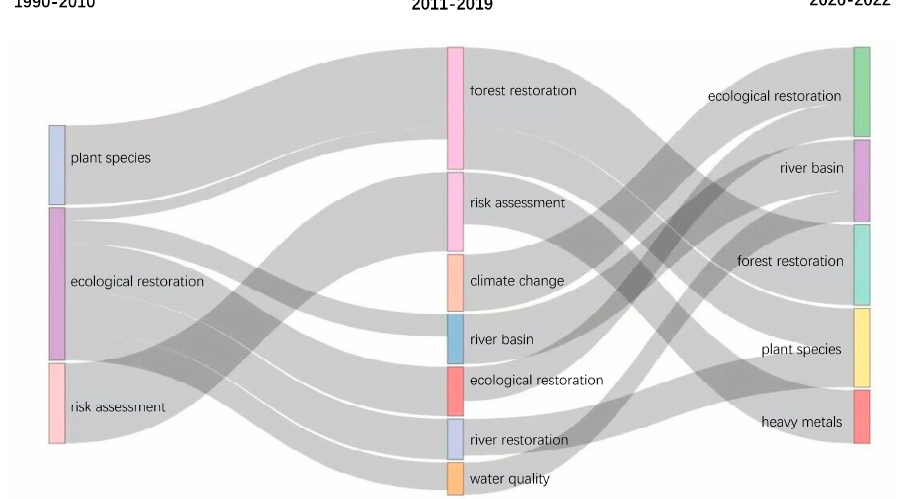
Figure 9. Evolution of research topics in the field of ecological restoration from 1990 to 2022.